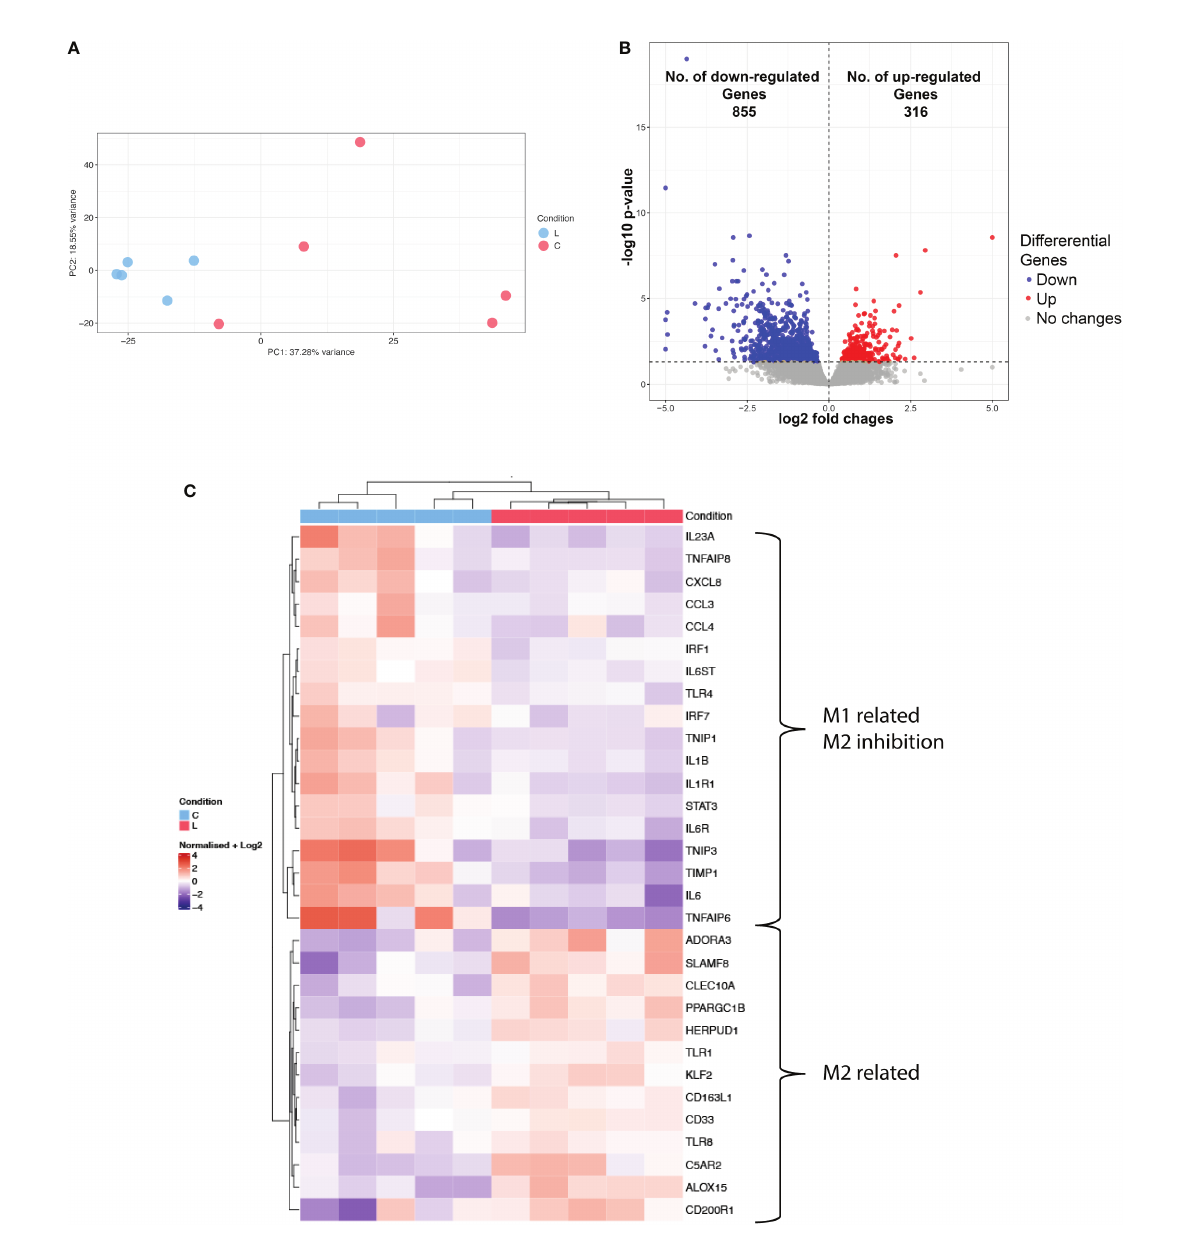
FIGURE 3 Transcriptional pro fi ling of CD11b+ of lipedema and control patients. (A) Principal component analysis of RNA-seq data show the characteristics of samples according to gene expression (B) Volcano plot of signi fi cantly differentially expressed genes (adj. p < 0.05) (C) Heatmap of hierarchical clustering showing expression patterns of selected differentially expressed macrophage-associated genes. Log2 normalized expression value: red indicates upregulation and blue indicates downregulation (N(L) = 5; N(C) =